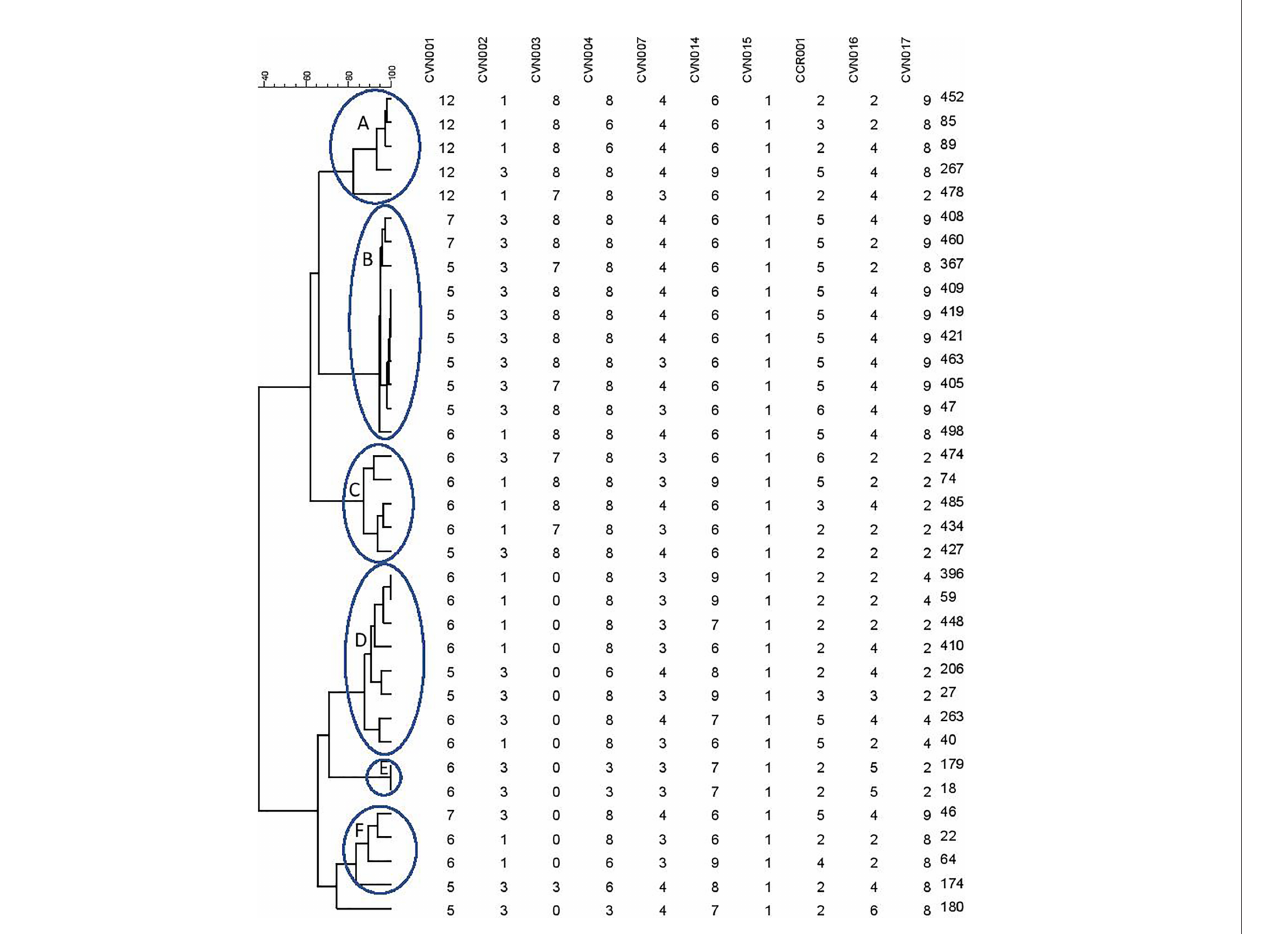
FIGURE 2 | Clustering results of b-lactamase-producing E. coli using 10-loci MLVA ( A – F clusters) differentiated UPGMA with the categorical coef fi cient of